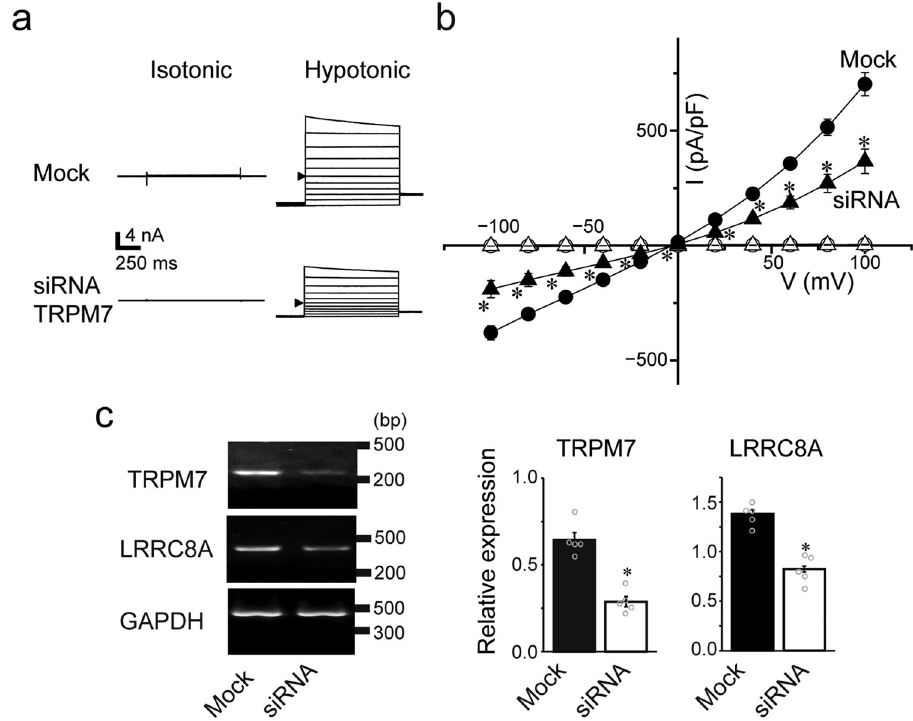
Fig. 1 TRPM7 expression is involved in VSOR activity and LRRC8A expression in HeLa cells. a Representative whole-cell current traces elicited by step pulses in isotonic and hypotonic conditions in Mock-transfected ( Mock ) and siRNA-TRPM7-treated ( siRNA ) cells. Arrowheads indicate currents at 0 mV. b Mean current ( I ) – voltage ( V ) relationships for swelling-activated whole-cell currents observed in Mock and siRNA cells ( n = 12 – 18). Each data point represents the mean ± SEM (vertical bar) of n samples. * P ( = 0.00053, 0.00036, 0.00028, 0.00024, 0.00033, 0.0018, 0.000083, 0.000085, 0.000091, 0.00010, and 0.00011 at − 100, − 80, − 60, − 40, − 20, 0, + 20, + 40, + 60, + 80, and + 100 mV, respectively) <0.005 compared to the Mock cell data by t -test. c Effects of TRPM7 knockdown on expression of TRPM7 and LRRC8A mRNAs. Left panel shows the PCR products from Mock or siRNA cells for TRPM7, LRRC8A, and the constitutively transcribed control, GAPDH. The nucleotide sequences of the PCR products obtained with TRPM7- and LRRC8A- speci fi c primers were completely identical to the corresponding sequences for TRPM7 (human: NM_017672) and LRRC8A (human: NM_001127244), respectively. Right panels show the bar graph representation of the relative expression values of the optical densities in pixels of the PCR bands of TRPM7 (left bars: 45.3 ± 5.1%) and LRRC8A (right bars: 59.4 ± 3.4%) in siRNA cells compared to those in Mock cells. The values were calculated from fi ve independent PCR ampli fi cations after normalization to the corresponding band of GAPDH control. * P ( = 0.00013 and 0.00010 for TRPM7 and LRRC8A , respectively) <0.0005 compared to Mock cell data by t